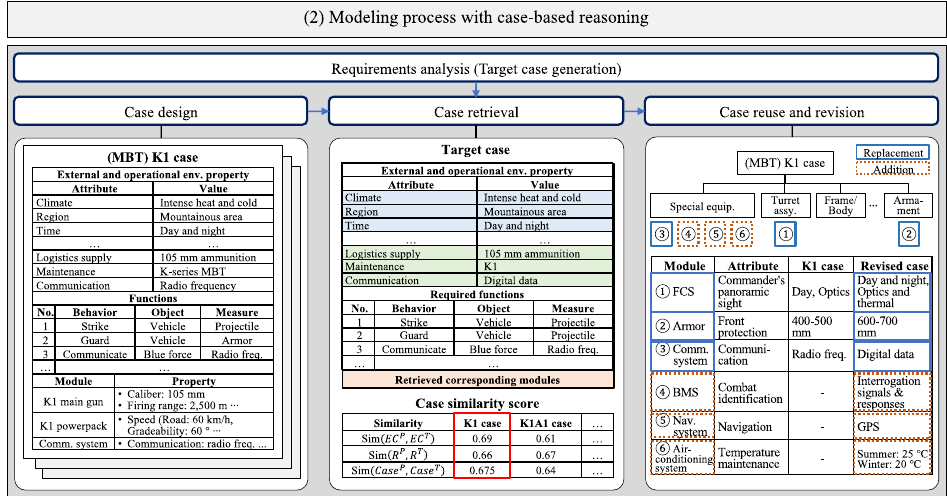
Figure 8. Flow of actions for the modeling process part (b).